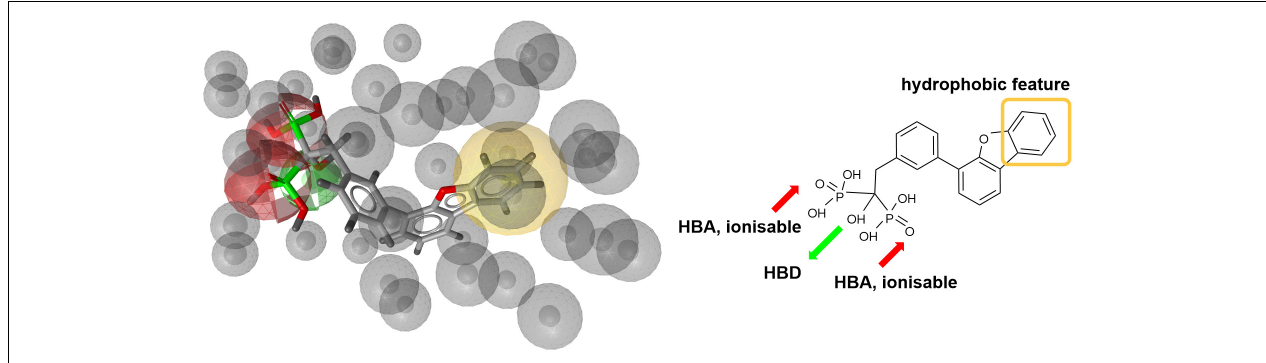
FIGURE 3 | Left: 3D representation of a pharmacophore model based on inhibitor BPH-629 (green spheres represent H-bond donating feature (HBD), red spheres represent H-bond acceptor feature (HBA) while yellow-colored sphere represents a lipohilic feature. Gray colored spheres are exclusion cones based on crystal structure PDB ID: 2E98); right is a 2D projection of BPH-629 inhibitor with explicitly defined pharmacophoric